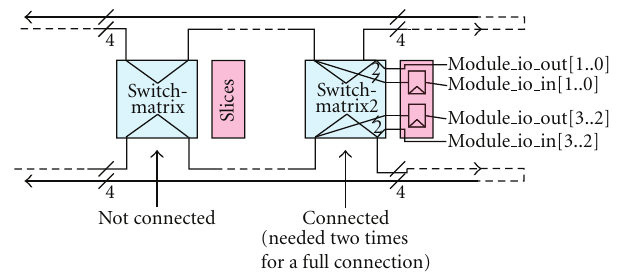
Figure 2: Streaming bar implemented through the FPGA routing